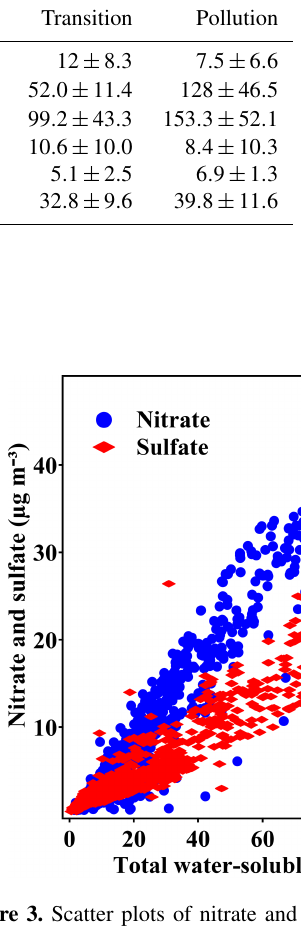
Figure 3. Scatter plots of nitrate and sulfate vs. WSIs during the